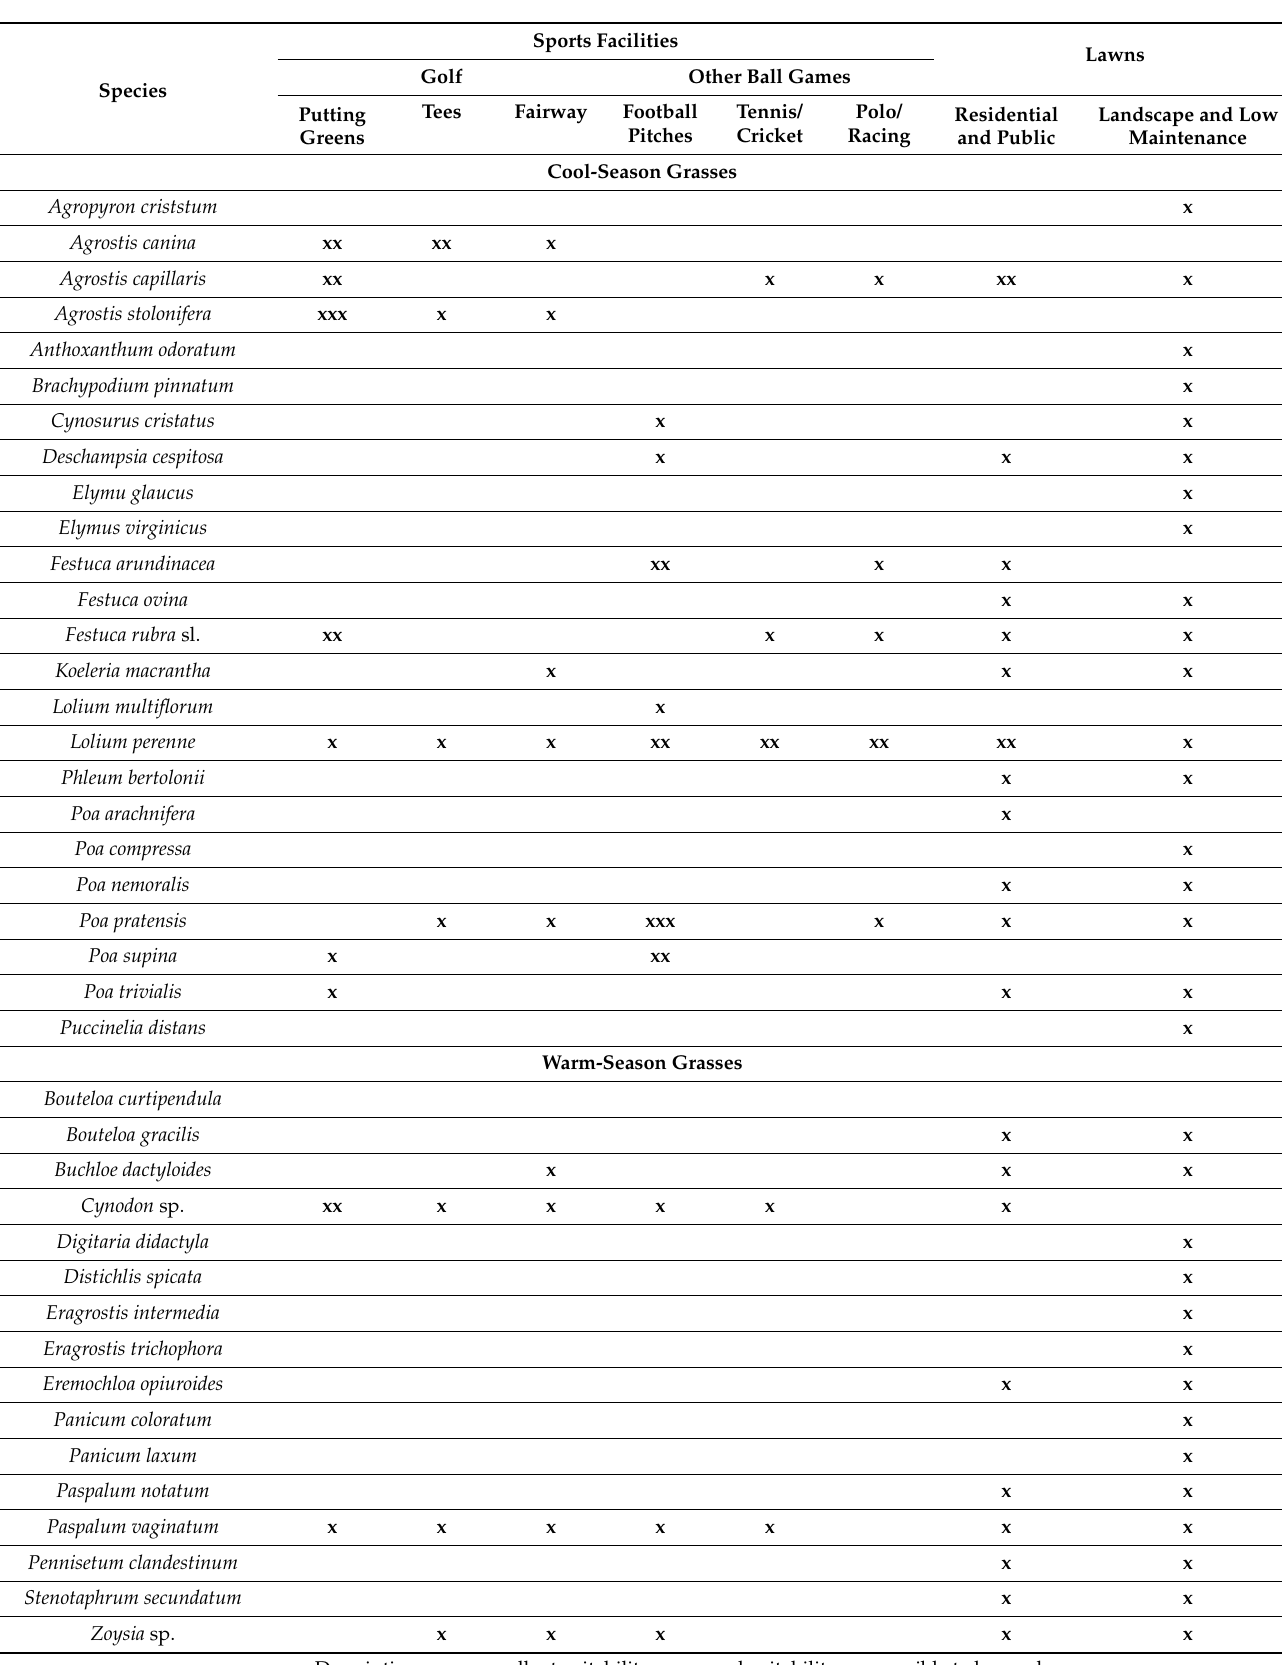
Table 2. Lawn grass species with the recommended